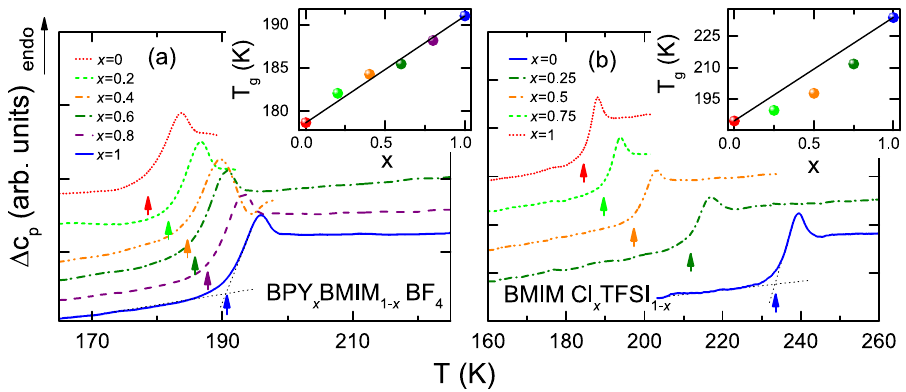
Figure 1. Shift of glass-transition temperature for two mixtures of ionic liquids. Differential Scanning Calorimetry heating traces of BPY x BMIM 1 − x BF 4 ( a ) with x = 0/0.2/0.4/0.6/0.8/1.0 and BMIM Cl x TFSI 1 − x ( b ) with x = 0/0.25/0.5/0.75/1.0 (endotherm up). The colored arrows mark the onset points used to determine T g . The dependence of T g on composition is shown in the insets, where the black lines indicate linear extrapolation of T g between x = 0 and